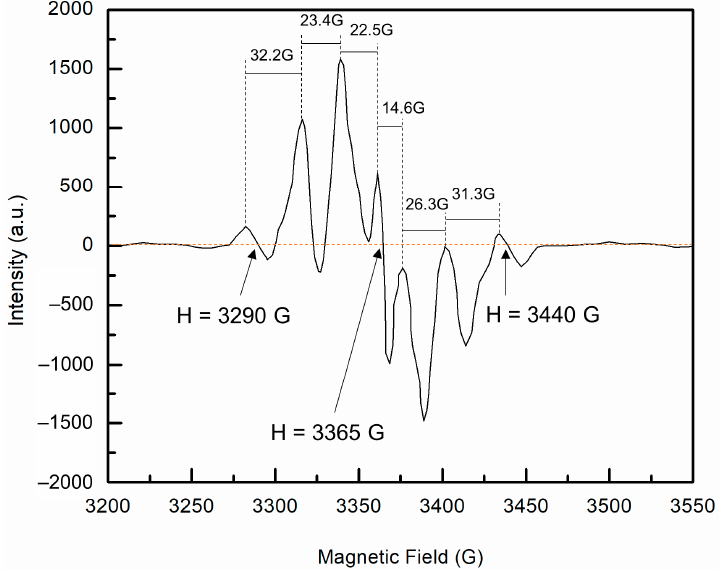
Figure 3. Electron paramagnetic resonance (EPR) spectra of ultra-high molar mass